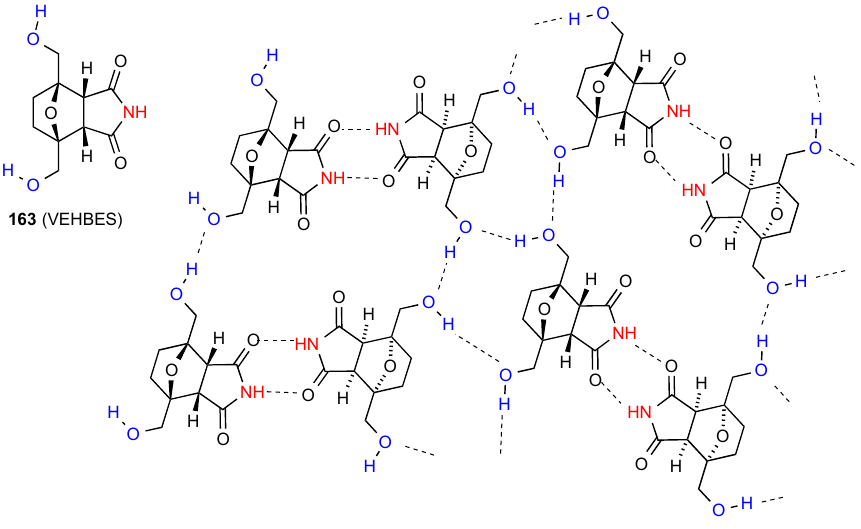
Figure 48. Structure adopted by compound 163.